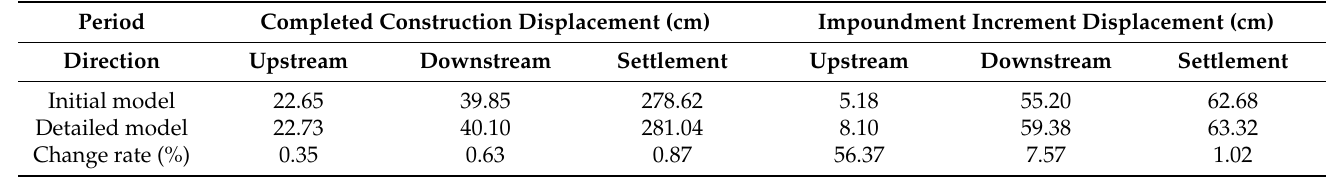
Table 5. The eigenvalue and rates change of the Pubugou dam simulated